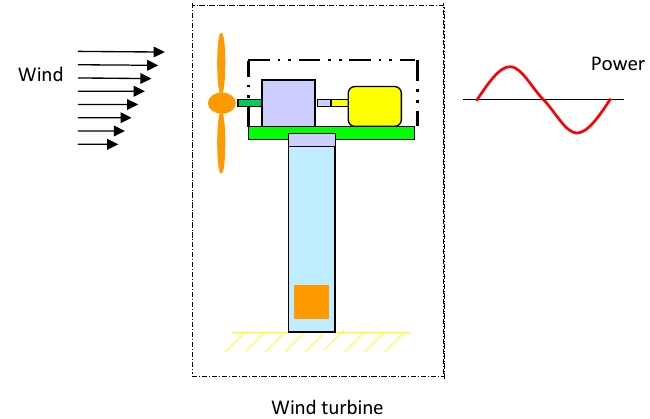
Figure 6. Energy conversion of WTs